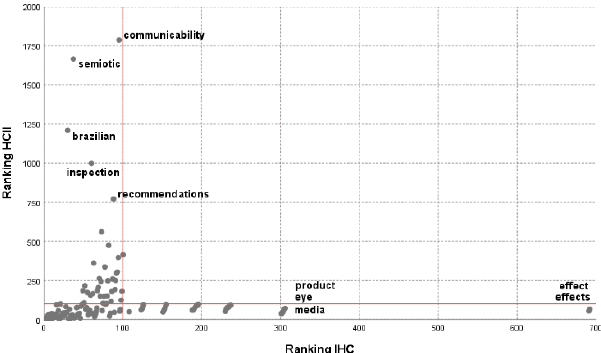
Figure 13. Scatterplot of the first 100 words of the ranking of each